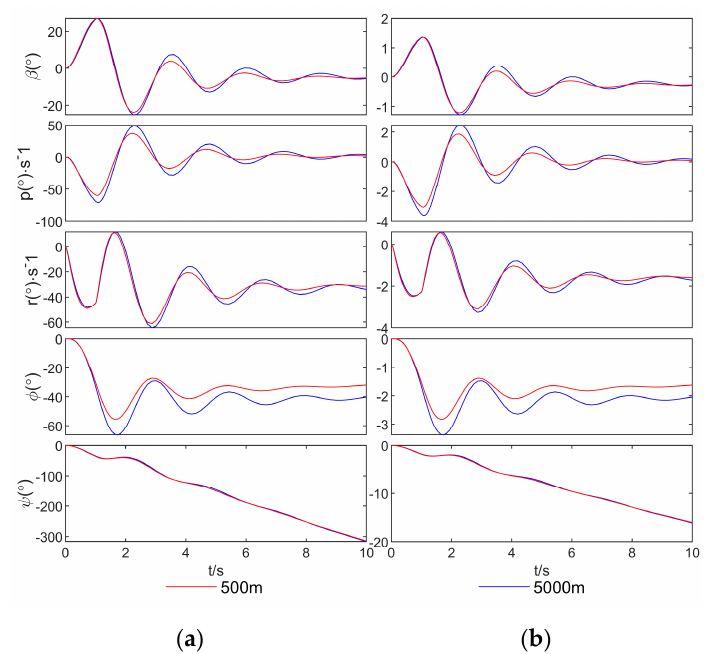
Figure 12. Free response of rudder deflection at low altitude and high altitude: ( a ) Rudder deflect 20 degree. ( b ) rudder deflect 1 degree.